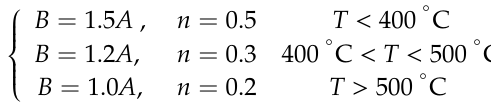
Figure 1. Schematic of the Voyiadjis-Abed-Rusinek (VAR) model-based modification of the JC model's initial yield stress parameter with corresponding mathematical equations with A0 representing the constant, A, of the JC model.